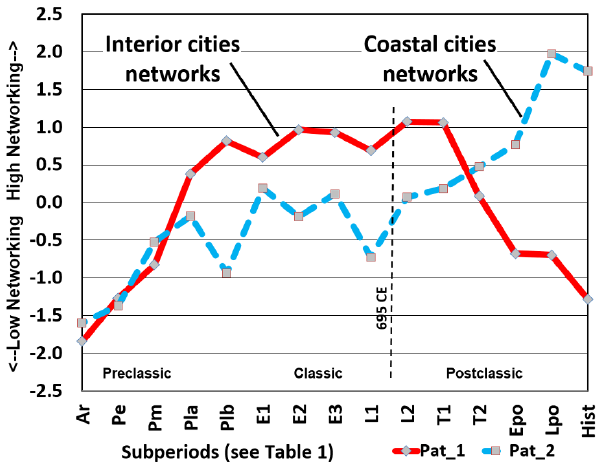
Fig. 7 . Patterns 1 and 2 plotted against time. Interior (diamonds) and coastal (squares) cities demonstrate different patterns of networking. Interior cities strongly networked during the Late Preclassic (Pla-Plb) and Classic (E1-L2) periods. Coastal cities linked intensively during the Postclassic (T2-Lpo) after a long slow period of development (plotted from patterns 1 and 2 scores, see Table